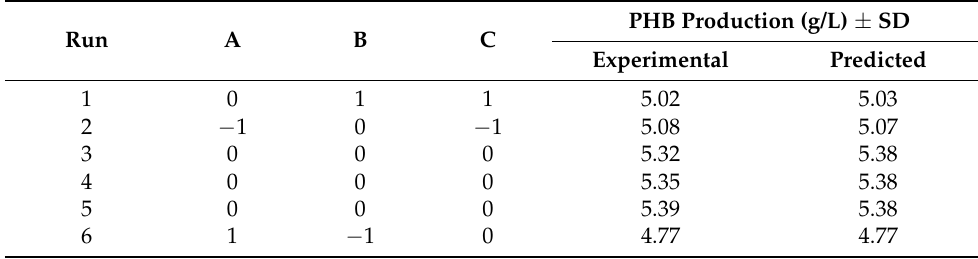
Table 2. BBD, along with experimental and predicted values of the dependent variable for PHB